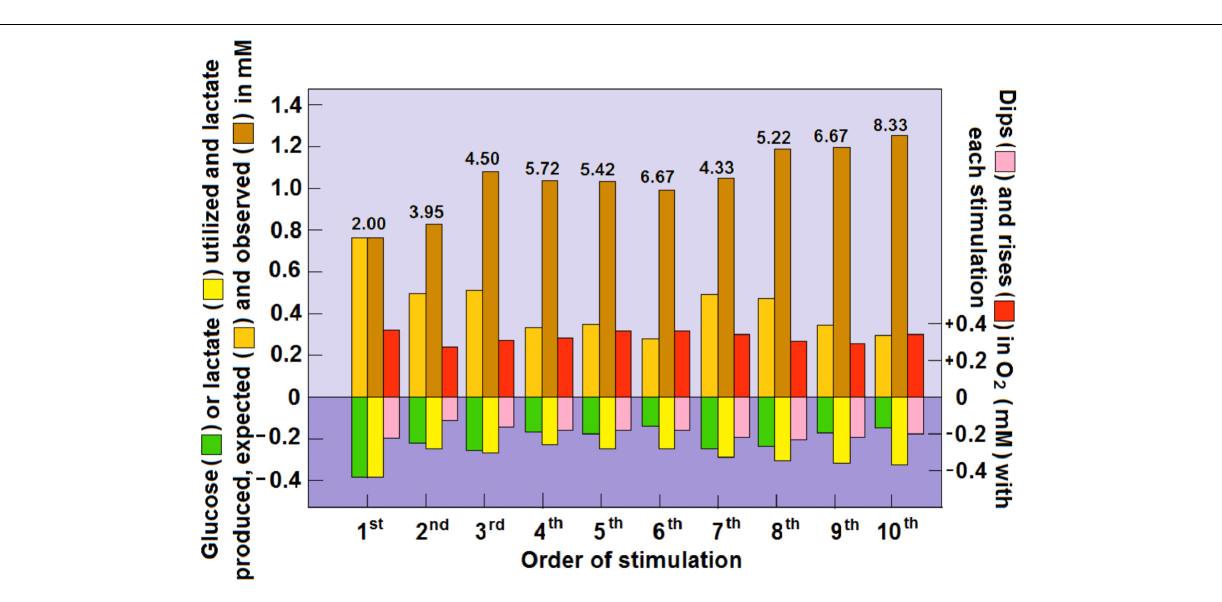
by Fox et al. (1988), involving the use of [ 15 O]H 2 O, [ 15 O]O 2